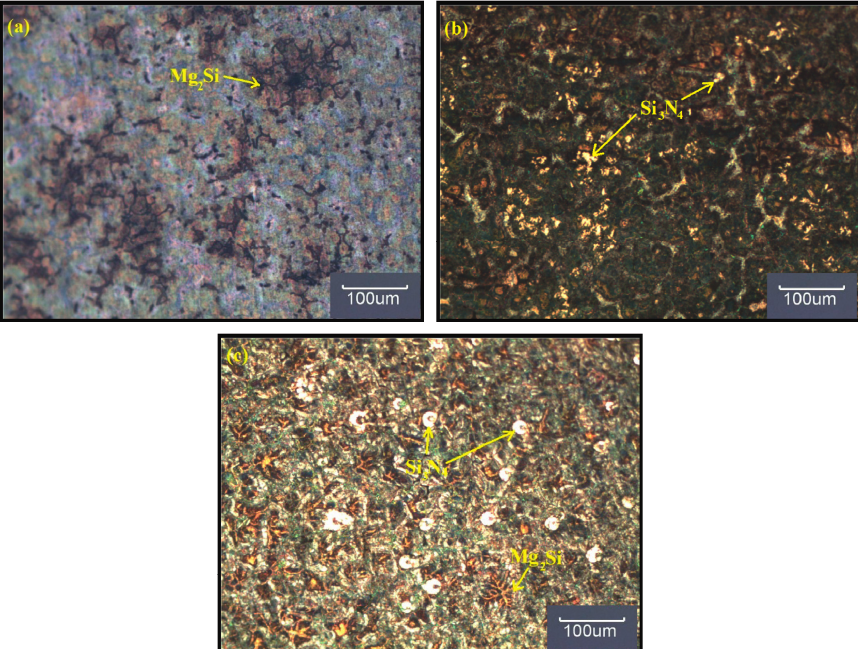
Figure 6: Optical photomicrograph of the (a) as-cast AA6061 alloy, (b) AA6061/15 wt.% Si composite.